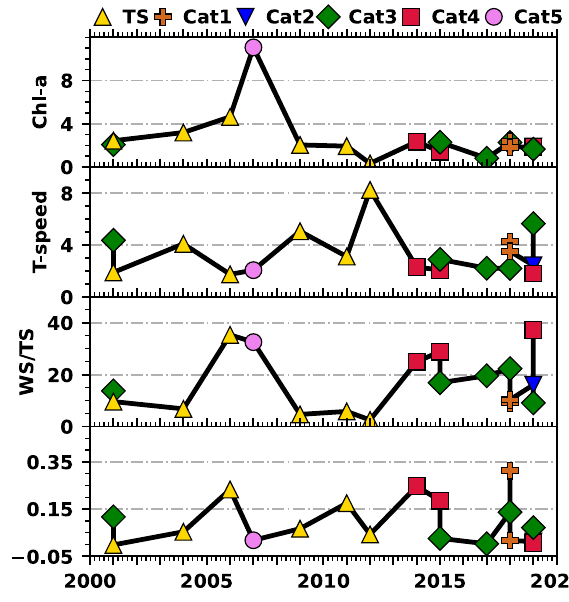
Fig. 6 The Chl-a blooms associated with cyclones in Arabian Sea. The observed enhancement in Chl-a (mg/m 3 ) following the cyclone passage (5-day average) over AS. The translational speed of the closest track points where the bloom occurred in (m/s), the ratio of wind speed to translational speed (WS/TS) and EPV when cyclone reached its maximum intensity (m/s) are also